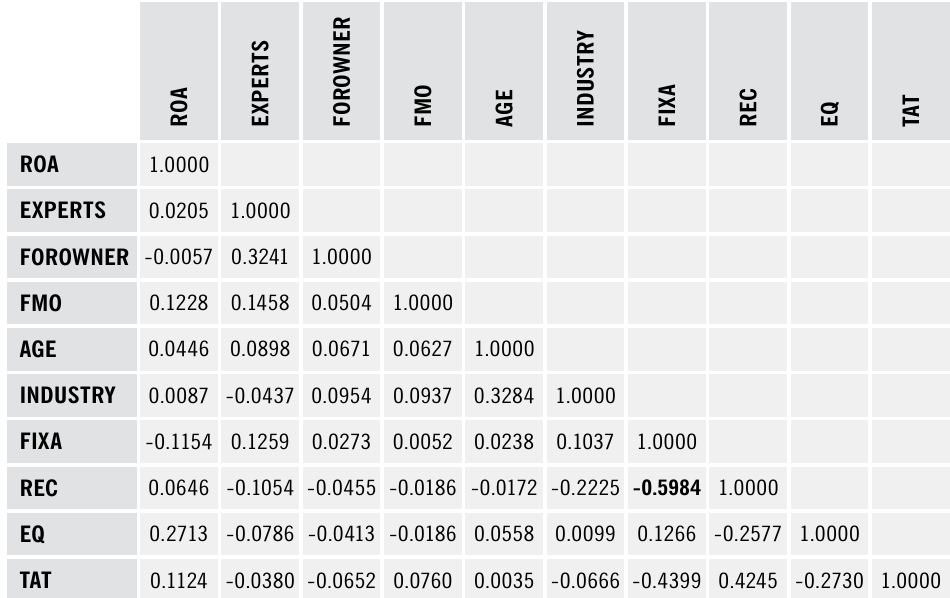
Table 5. Correlation matrix –